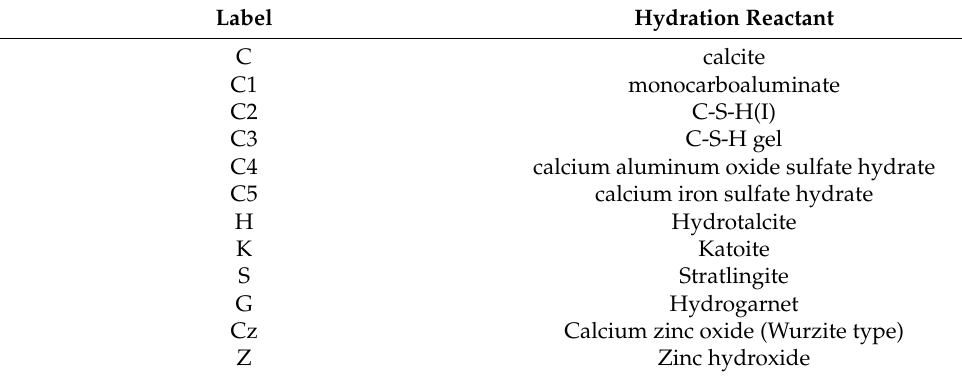
Table 4. Hydration reaction summary (in Figures 3 and 4).